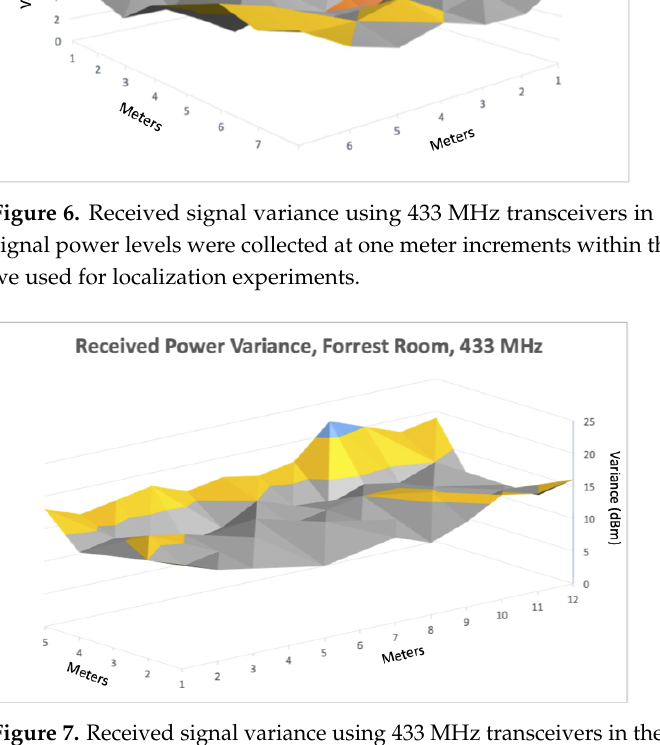
Figure 7. Received signal variance using 433 MHz transceivers in the mixed use, Forrest Room space. Received signal power levels were collected at one meter increments within the space that contained the path we used for localization experiments.